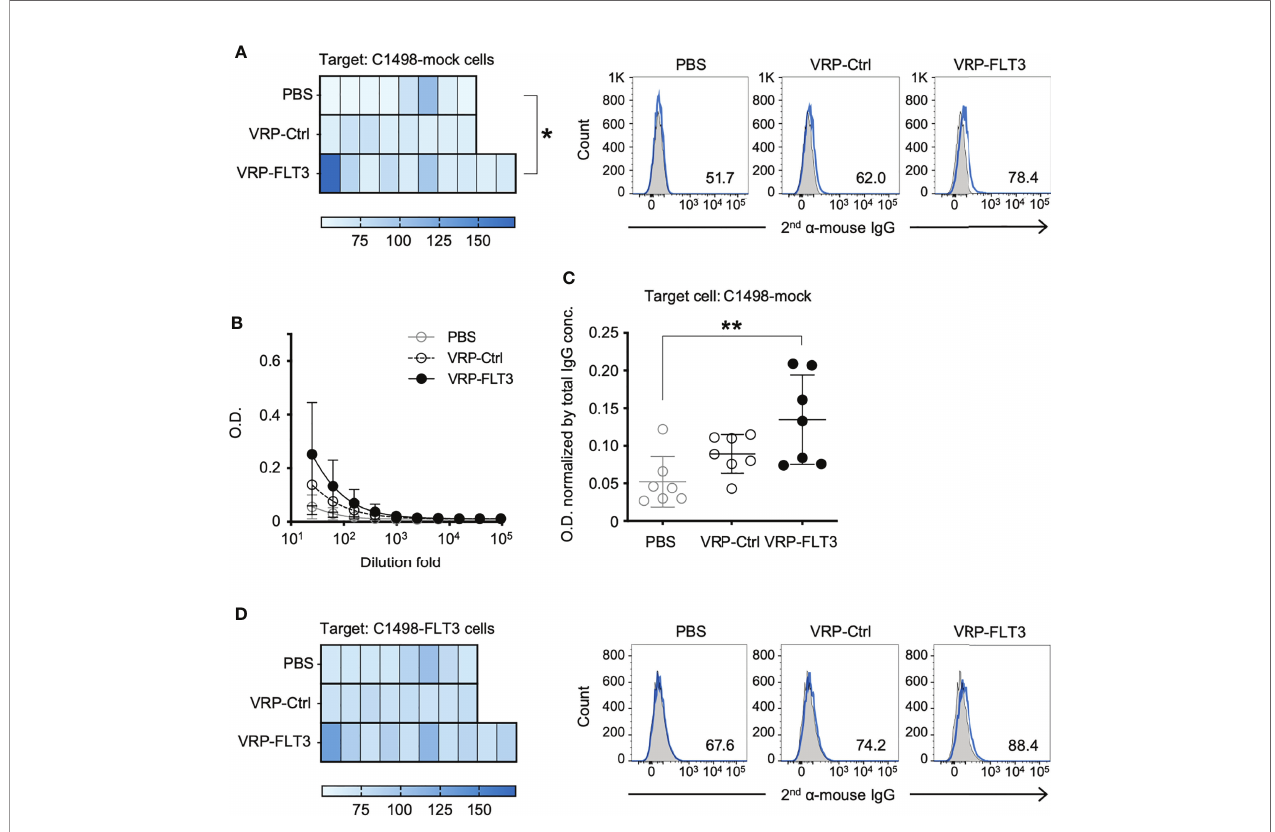
FIGURE 6 | VRP-FLT3 vaccination induces broad reactivity of antibody to mouse leukemia cell membrane antigens. Mice challenged with C1498-FLT3 tumor cells were vaccinated as described in Figure 1 . Plasma samples collected on days 35-42 were diluted and were incubated with (A) C1498-mock cells or (D) C1498- FLT3 at a level of 1 ug total IgG per reaction. The tumor cell-bound IgG was detected by a fl uorophore-conjugated secondary anti-mouse IgG antibody using fl ow cytometry. Heatmaps of MFI of each sample are shown (n=8 or 10 per group). Statistical signi fi cance was determined by Kruskal-Wallis test (nonparametric) ANOVA, *P<0.05. A representative sample of each group is shown in Heatmaps on the right (2 nd antibody alone in shade grey and samples in blue line). (B, C) Plasma IgG bound to C1498-mock membrane extracts were determined by ELISA. Days 35-42 plasma samples were tested. (B) Titration curves (symbols represent the mean values in each group). (C) O.D. values obtained with 1:25 diluted plasma were normalized by the IgG concentration of each sample (O.D. / total IgG concentration). Each symbol represents an individual mouse (n=7 per group). Bars represent the mean ± SD. Statistical signi fi cance was determined by one-way ANOVA,